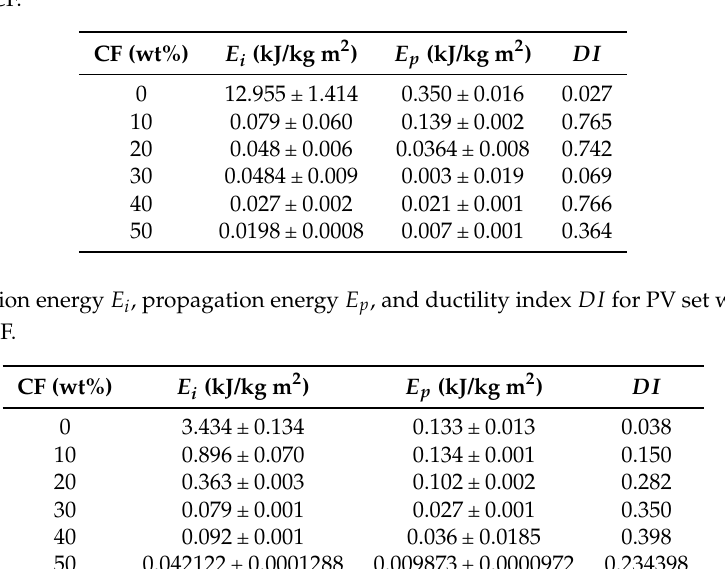
Table 2. Initiation energy E i , propagation energy E p , and ductility index DI for the PP set with different filler content, CF.